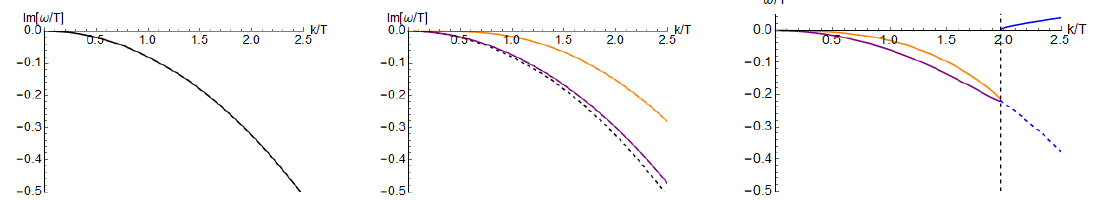
Figure 7 . The dynamics of the hydrodynamic modes in the case of an elastic plasma, with the di(cid:11)usive charge mode omitted. Left: at zero chemical potential and zero elasticity, the di(cid:11)usion modes of the transverse collective excitations superimpose each other. Center: at (cid:12)nite chemical potential and small elasticity, the two di(cid:11)usion constants become di(cid:11)erent and smaller than the (cid:22) = 0 value (dashed line). Right: increasing the rigidity of the system, the two modes collide and produce a propagating sound mode in a k -gap fashion. The higher the rigidity, parameterized by (cid:11) 3 =T , the more the momentum gap moves towards the origin and eventually disappears. In this sense, the physics in the central and right panels is qualitative the same. See (cid:12)gure 8 for a detailed analysis of the recombination point as a function of (cid:11) 3 =T